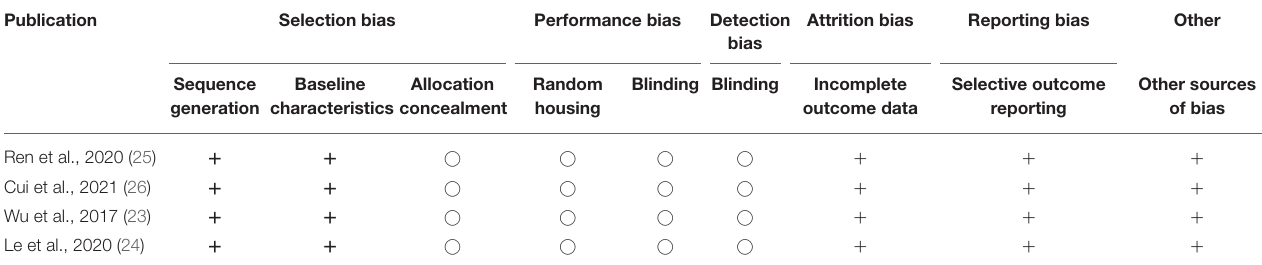
TABLE 2 | Evaluation of the study quality with the SYRCLE’s risk of bias tool ( + : no or minimal risk of bias. − : high risk of bias, (cid:13) : not reported).